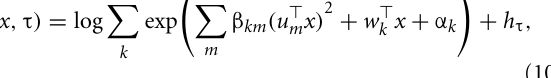
would not have been able to recover the true filter. (D) Adding higher-frequency components allows us to represent the true filter but also increases the error in the estimated filter. (E) Amplitude spectra of the true filter (blue line) and the estimated filter (black solid line) of the toy neuron. The shaded region indicates a 90% confidence interval revealing high uncertainty in the high-frequency components of the estimated filter. The spectrum of the stimulus is shown as a gray line for reference (cf. Figure 2C